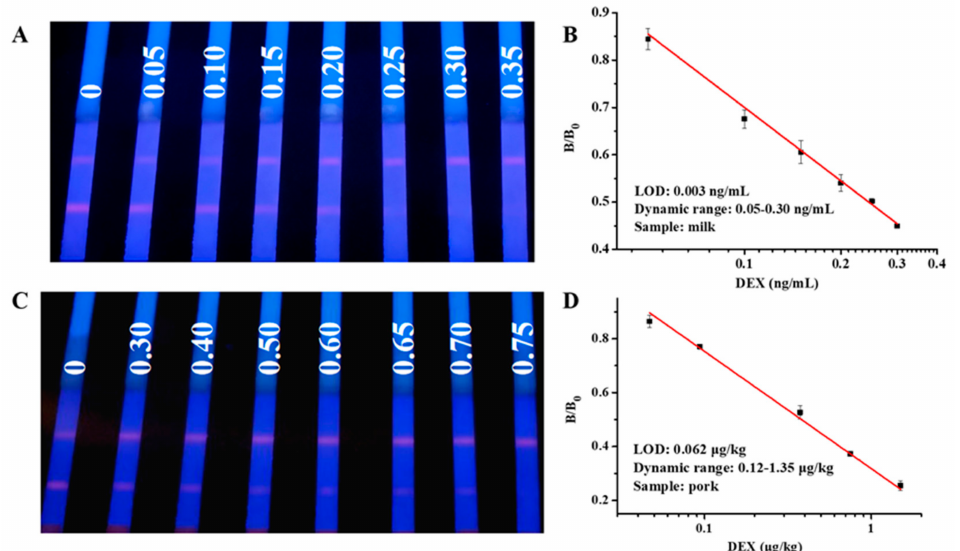
Figure 4. The results of TRFM-ICG for milk and pork detection: ( A ) the cut-off value for milk was 0.25 ng/mL; ( B ) calibration curve for quantitative detection of DEX in milk; ( C ) the cut-off value for pork was 0.7 µ g/kg; and ( D ) calibration curve for quantitative detection of DEX in